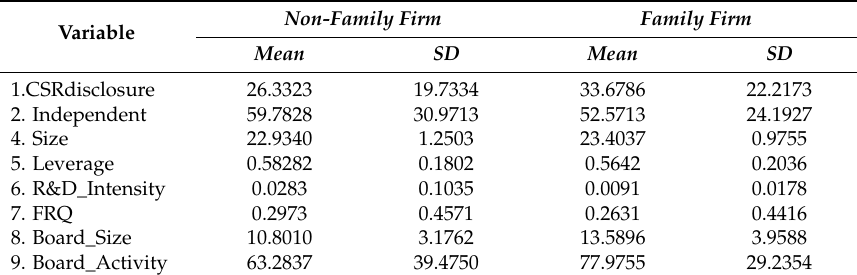
Table 5. Descriptive Statistics of family and non-family